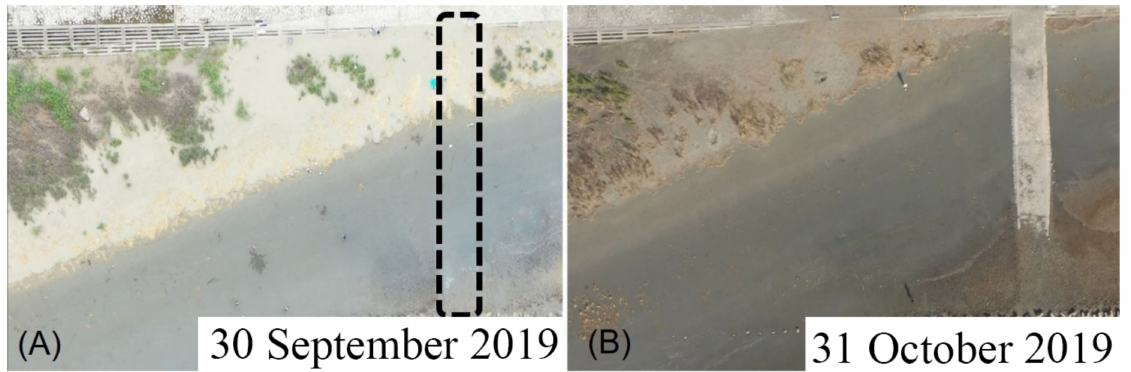
Figure 15. The ortho aerial photographs obtained using the DJI drone ( A ) on 30 September 2019 (before the typhoon) and ( B ) on 31 October 2019 (after the typhoon). The location is shown in Figure 2 ( bottom panel ). The dike shown in the right panel was buried by sediment before the typhoon occurred and is marked by the dashed line in the left